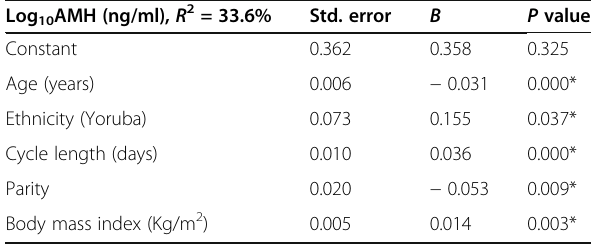
Table 3 Multivariable linear regression analysis Log 10 AMH (ng/ml), R 2 =